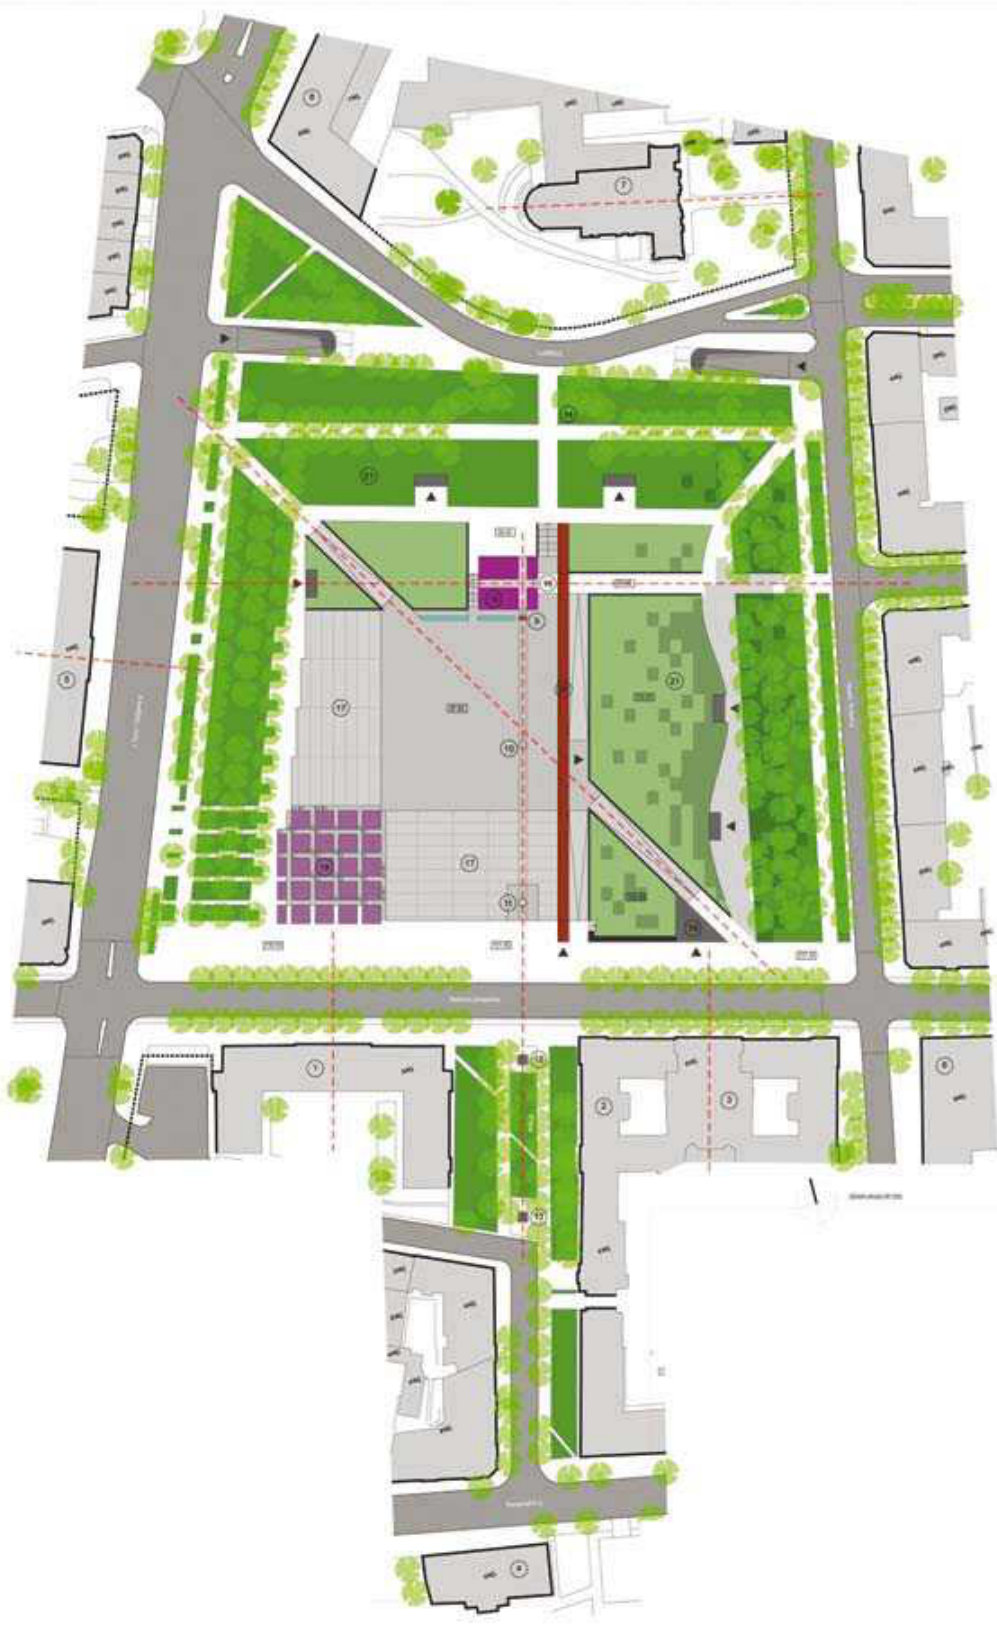
Fig. 17. Principal scheme of Lukiškės Square architectural and urban